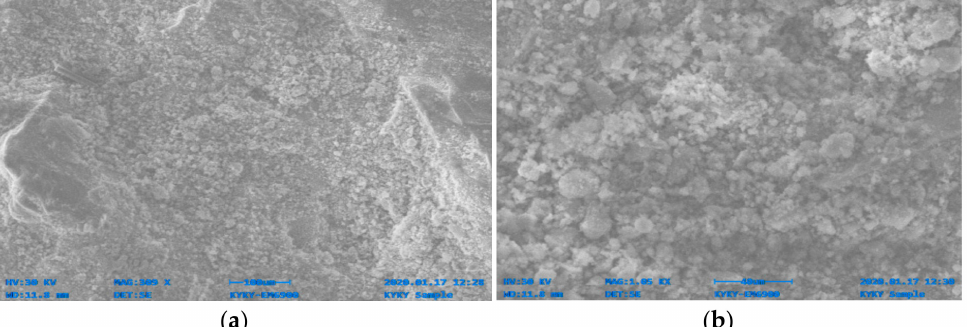
Figure 14. The SEM image of GPC-A0F mix specimen; ( a ) magnification 309 × ; and ( b ) magnification 1.05 × .